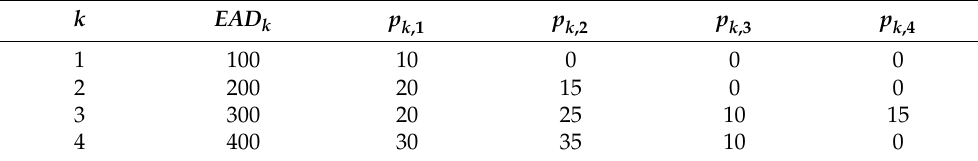
Table 8. Portfolio with K = 4 debt positions substituting missing data with 0.